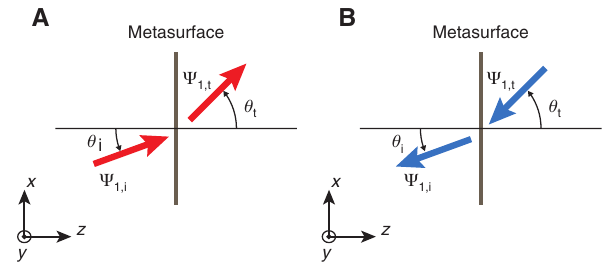
Figure 10: Representation of the two transformations specified in system (57): (A) first transformation corresponding to the fields in (58) and (59) and (B) second transformation corresponding to the fields in (60) and (61).